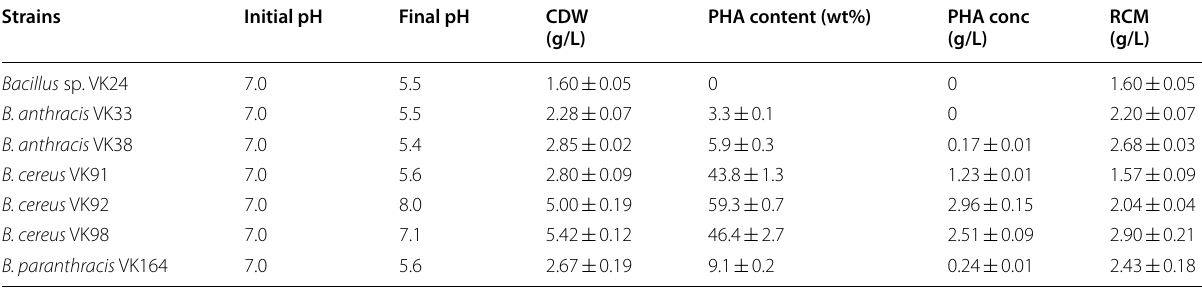
Table 4 Growth and PHA accumulation by seven isolated Bacillus species in the medium containing 20 g/L reducing sugars produced by saccharification of aqueous ammonia‑pretreated rice straw